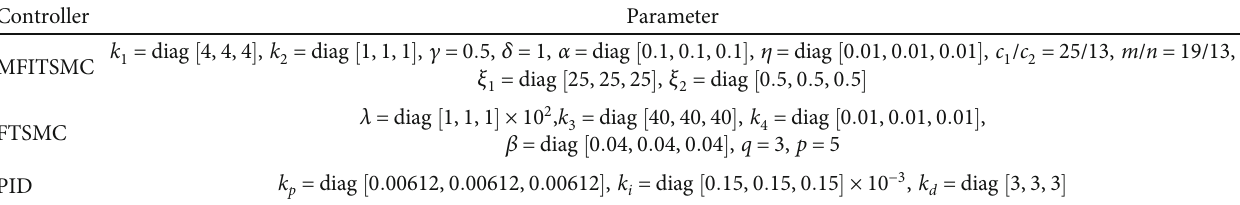
Figure 5: Block diagram of the MFITSMC controller for the follower spacecraft. Table 1: Controller parameters for numerical simulation.